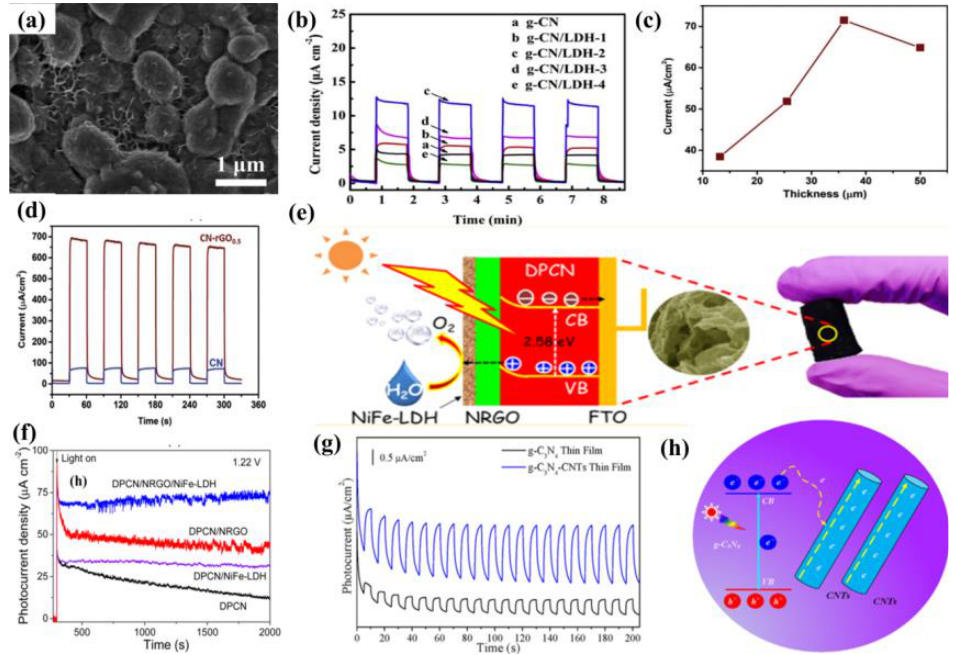
Figure 15. ( a ) SEM images of g−CN /LDH with 10 mC electric quantity. ( b ) i – t curves of g−CN and g−CN /LDH composites with different LDH amount under chopped light. Reprinted with permission from ref. [141] Copyright 2019 Elsevier. ( c ) The photocurrent-thickness relationship. ( d ) Photocurrent response in 0.1M KOH and10% TEOA aqueous solution at 1.23 V vs. RHE upon illumination of one sun. Reprinted with permission from ref. [145] Copyright 2018 Wiley-VCH. ( e ) The photographs, FESEM image and charge transfer mechanism. ( f ) Transient photocurrent responses under AM 1.5G irradiation at 1.22 V vs. RHE. Reprinted with permission from ref. [142] Copyright 2016 American Chemical Society. ( g ) Photocurrent response of g−CN−CNTs compared with pure g−CN thin film in 0.5M Na 2 SO 4 at 0 V vs. RHE. ( h ) Schematic illustration of charge transfer mechanism. Reprinted with permission from ref. [91] Copyright 2017 Elsevier.